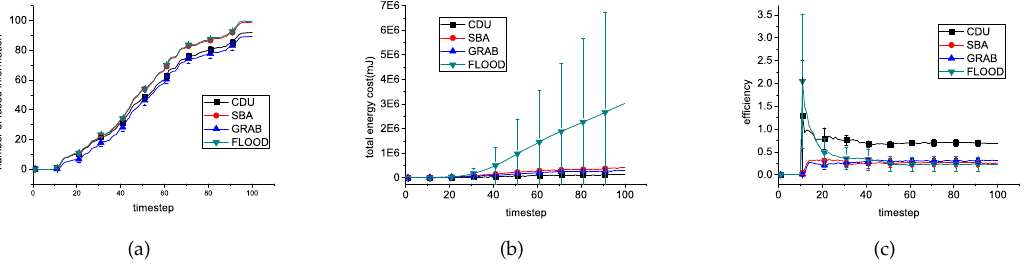
Figure 4. Experimental results for 500 sensors using different algorithms to fuse revelent